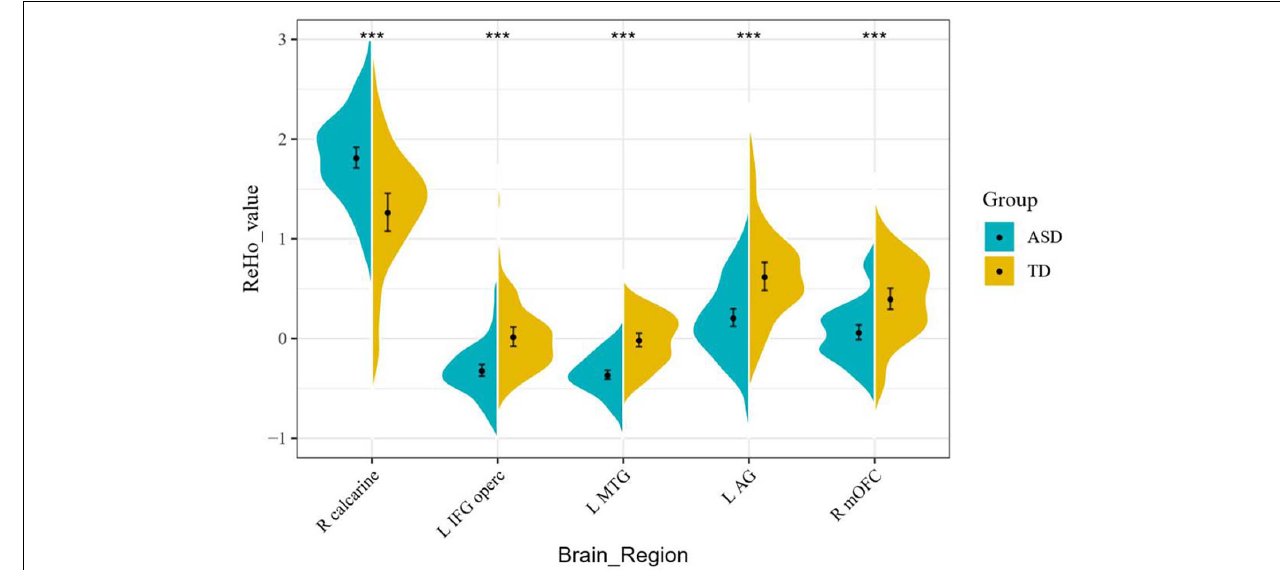
FIGURE 2 | ReHo signal values for altered regional brain regions between ASD boys and